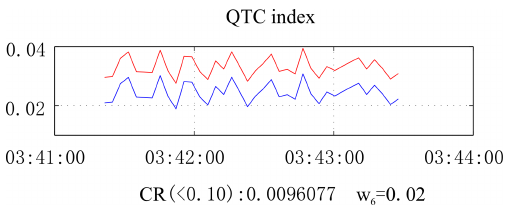
Figure 13. QTC index of original data (blue) and simulated data of harmonic-energy-ratio variation (red).